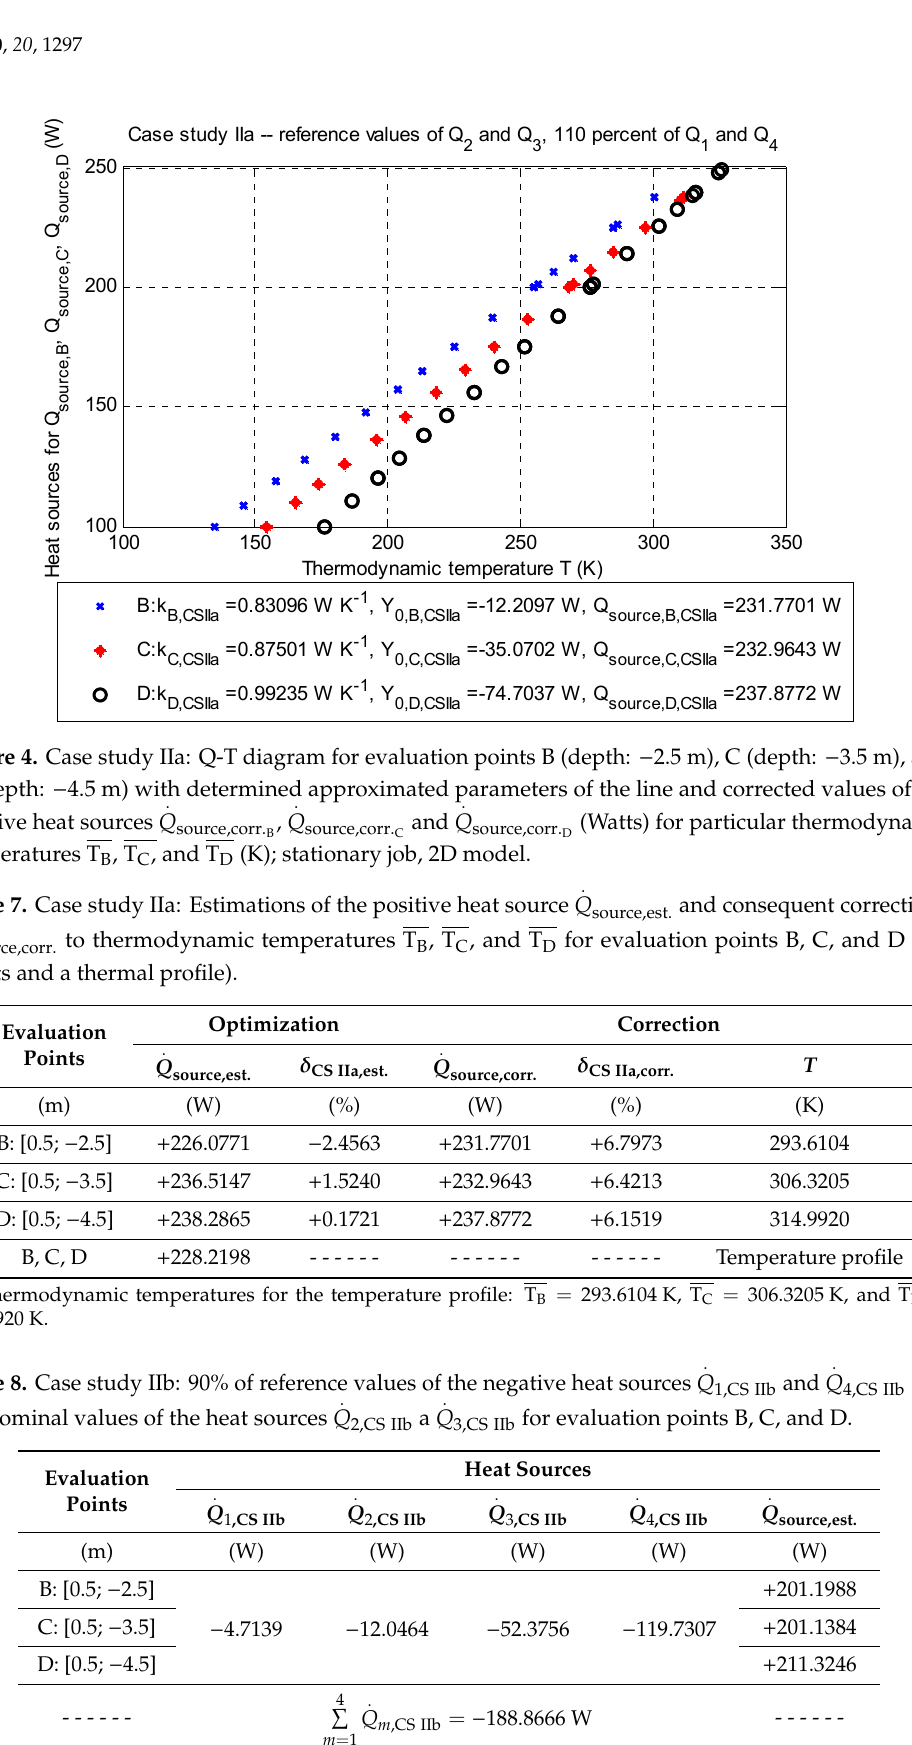
Table 8. Case study IIb: 90% of reference values of the negative heat sources 𝑄(cid:4662) (cid:2869),(cid:2887)(cid:2903) (cid:2893)(cid:2893)(cid:2912) and 𝑄(cid:4662) (cid:2872),(cid:2887)(cid:2903) (cid:2893)(cid:2893)(cid:2912) and the nominal values of the heat sources 𝑄(cid:4662) (cid:2870),(cid:2887)(cid:2903) (cid:2893)(cid:2893)(cid:2912) a 𝑄(cid:4662) (cid:2871),(cid:2887)(cid:2903) (cid:2893)(cid:2893)(cid:2912) for evaluation points B, C, and D.